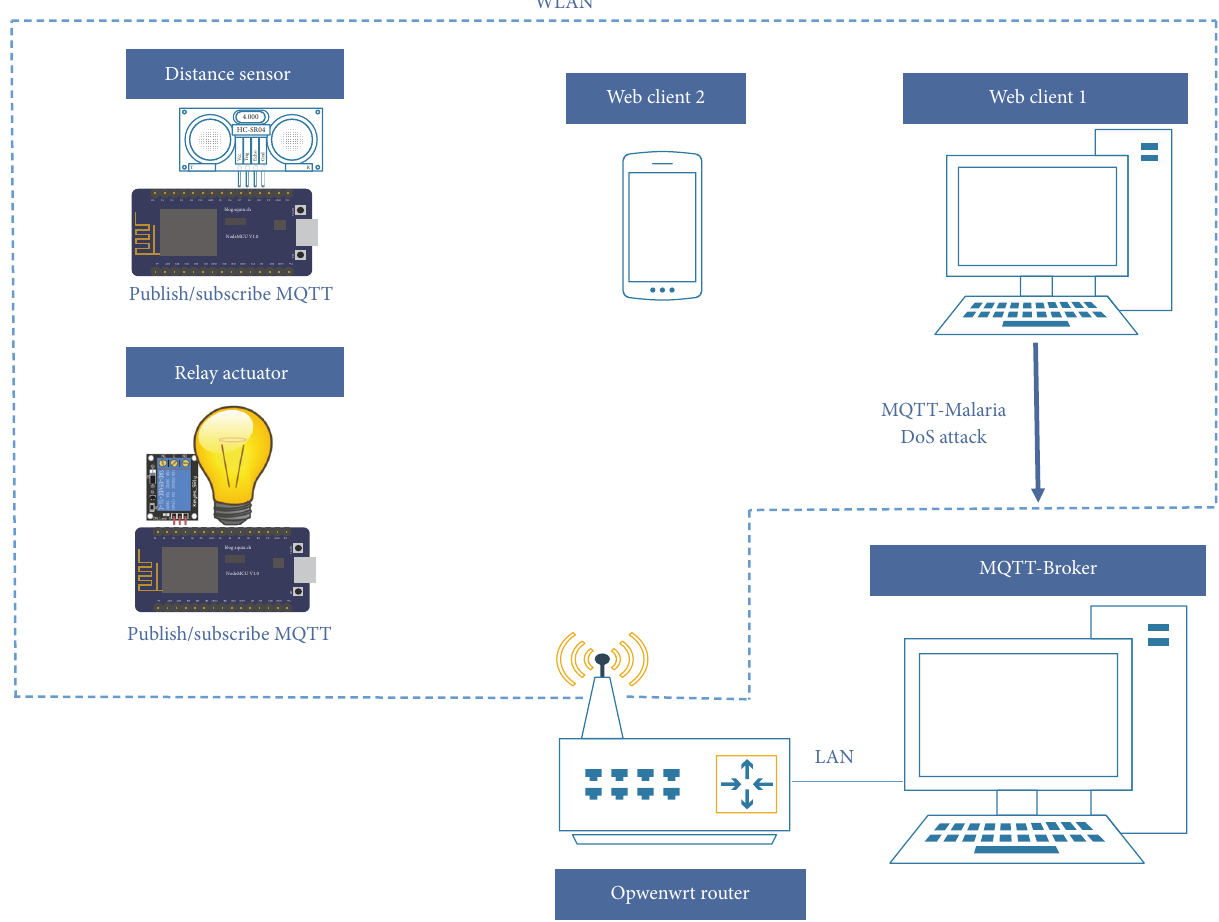
Figure 1: Test environment